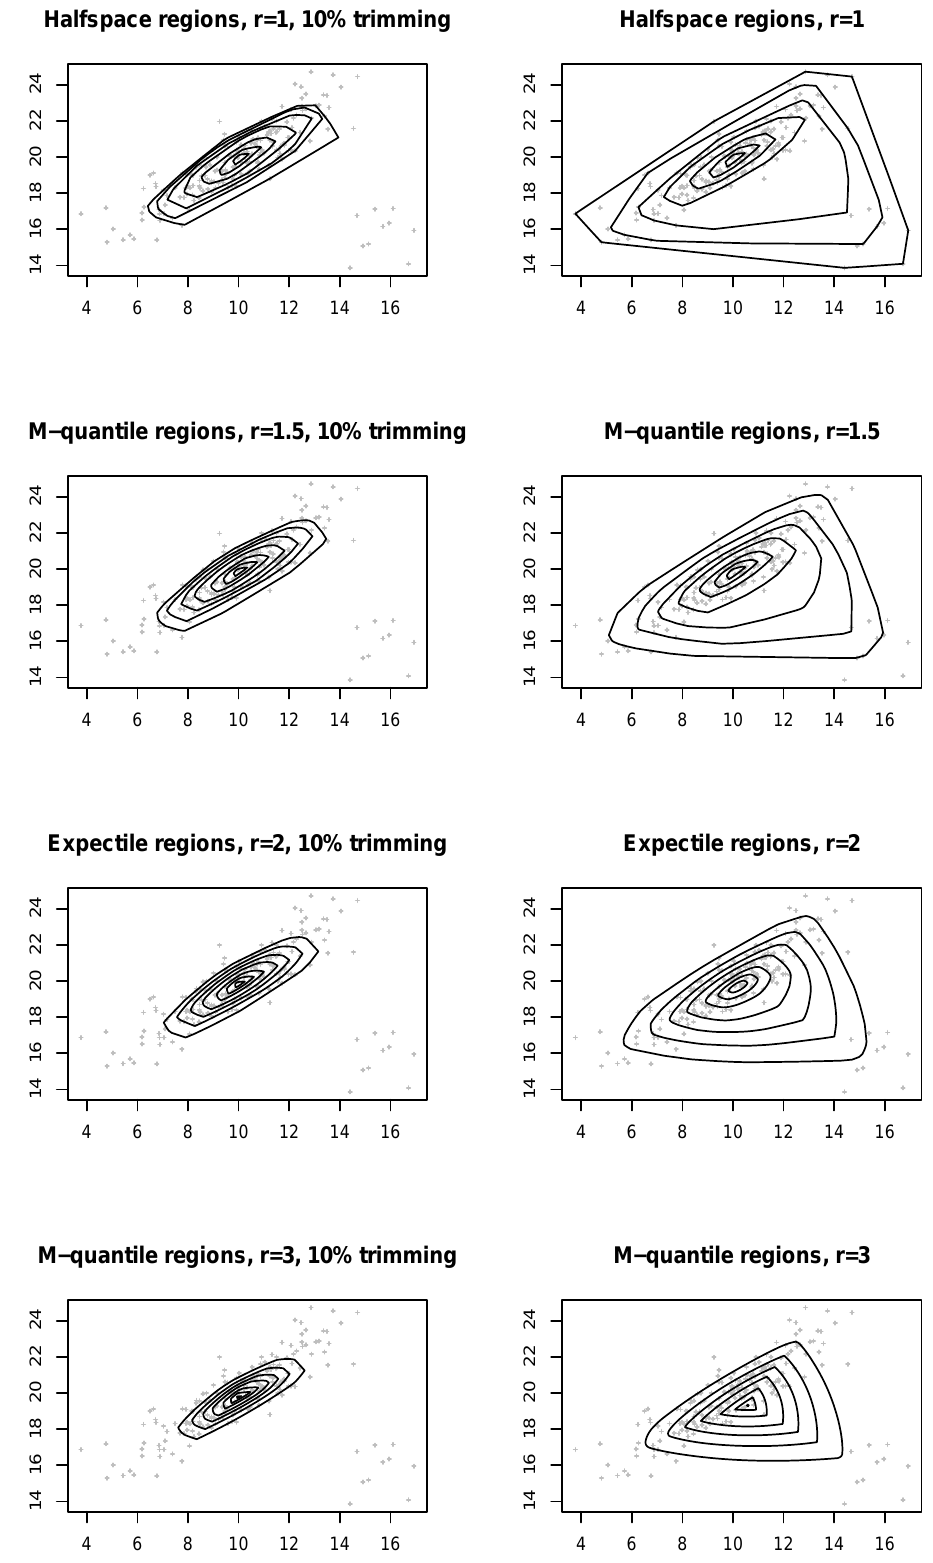
Figure 1. M -quantile regions including halfspace and expectile ones with 10% of trimming and